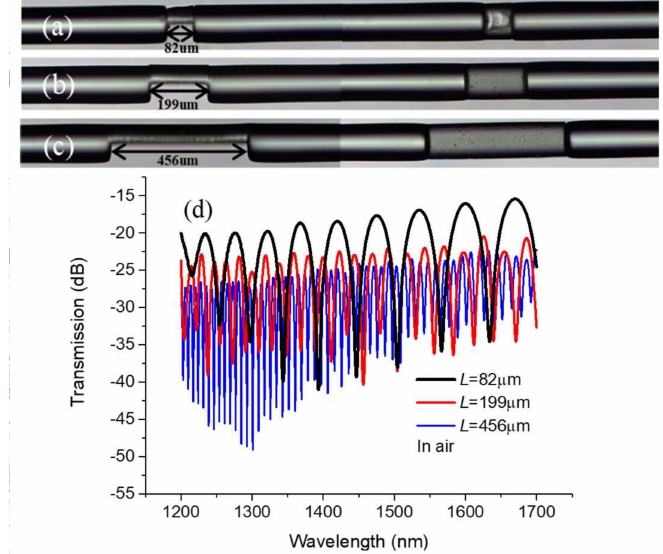
Figure 2. ( a – c ) Side and top view microscopic images of the MCMZIs with different cavity lengths of 82 µ m, 199 µ m, and 456 µ m; ( d ) Transmission spectra of the MCMZIs in air corresponding to ( a – c